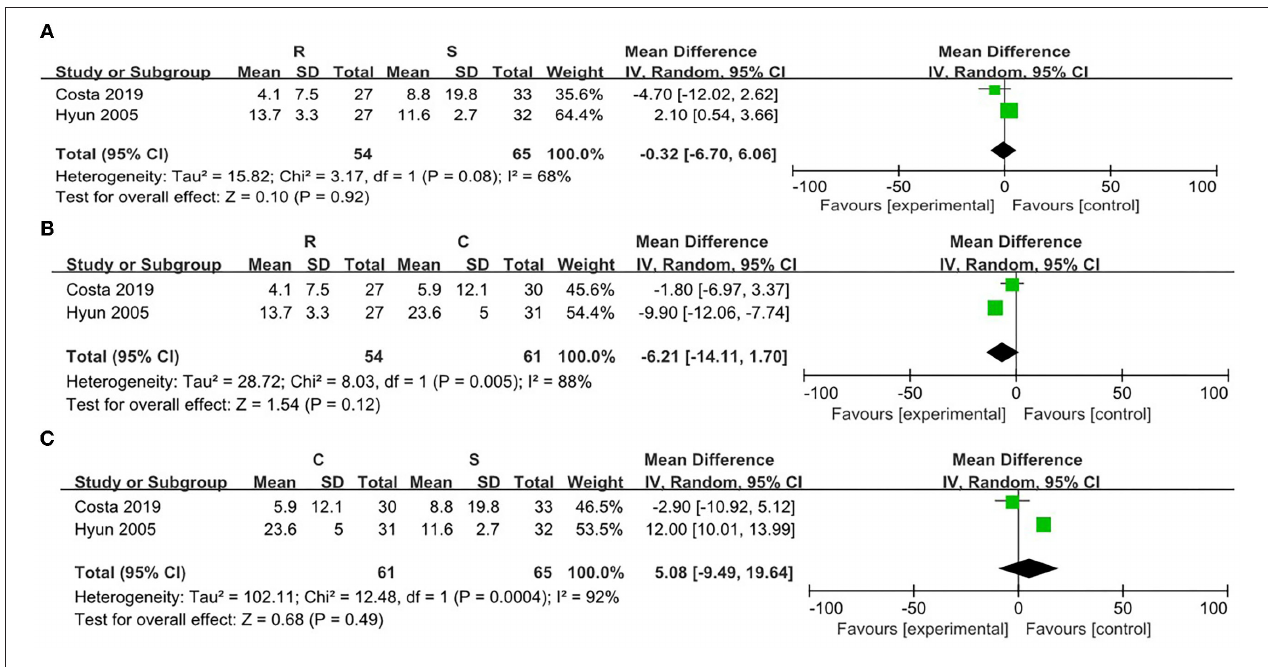
FIGURE 7 | Risk evaluation for the bias of the literatures at T4. (A) CRP vs. SRP; (B) RRP vs SRP; (C) RRP vs.